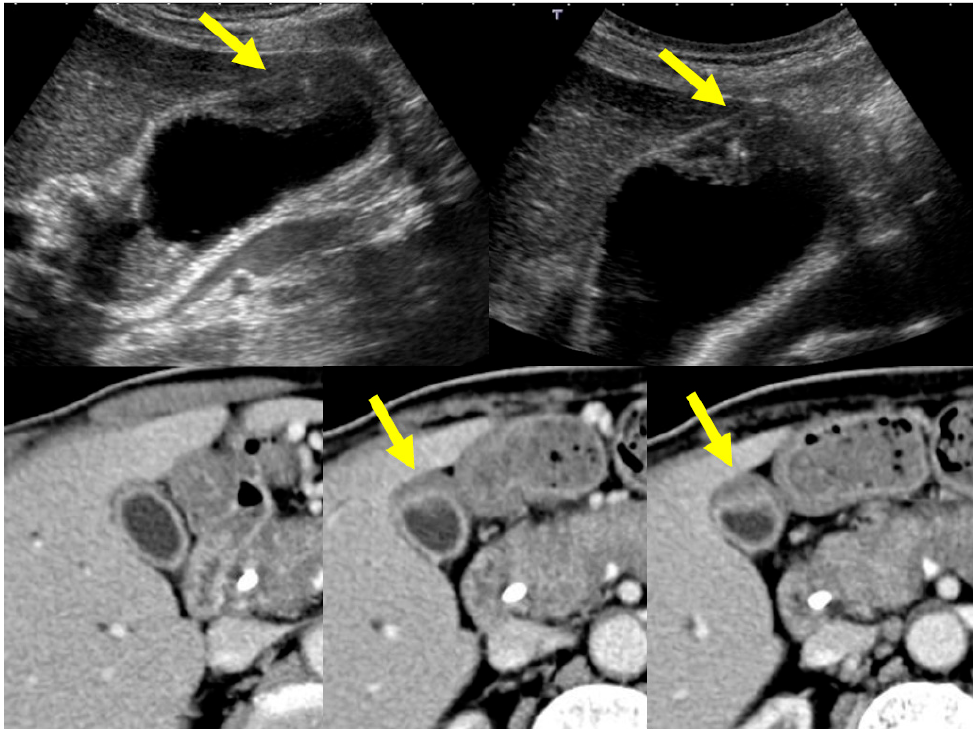
Figure 10. US (raised-floor type) and CT (raised-floor’ type) findings of a case with a localized type of IgG4-sclerosing cholecystitis (arrows). CT (Figures 11 and 12):